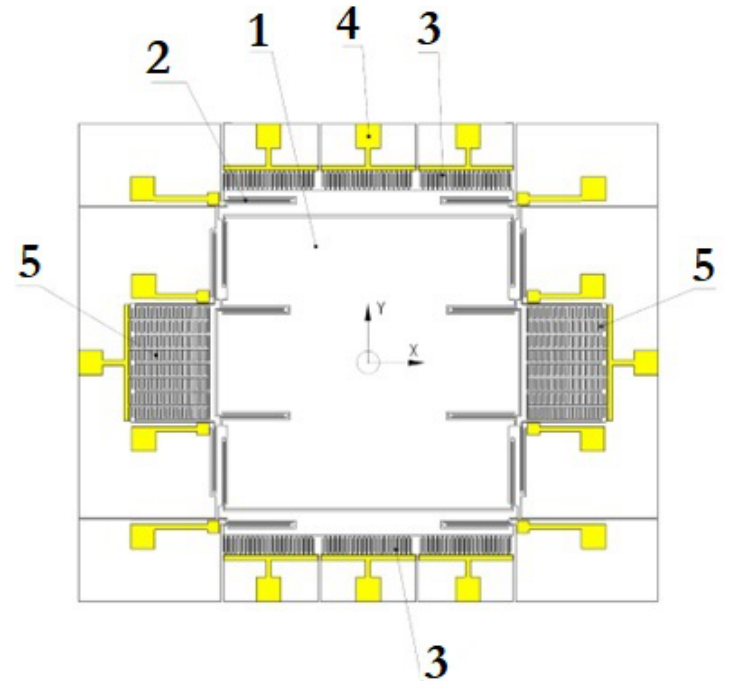
Figure 4. The developed structure: the topology of the SE of the MEMS gyroscope, ( 1 ) IM, ( 2 ) U-beam,